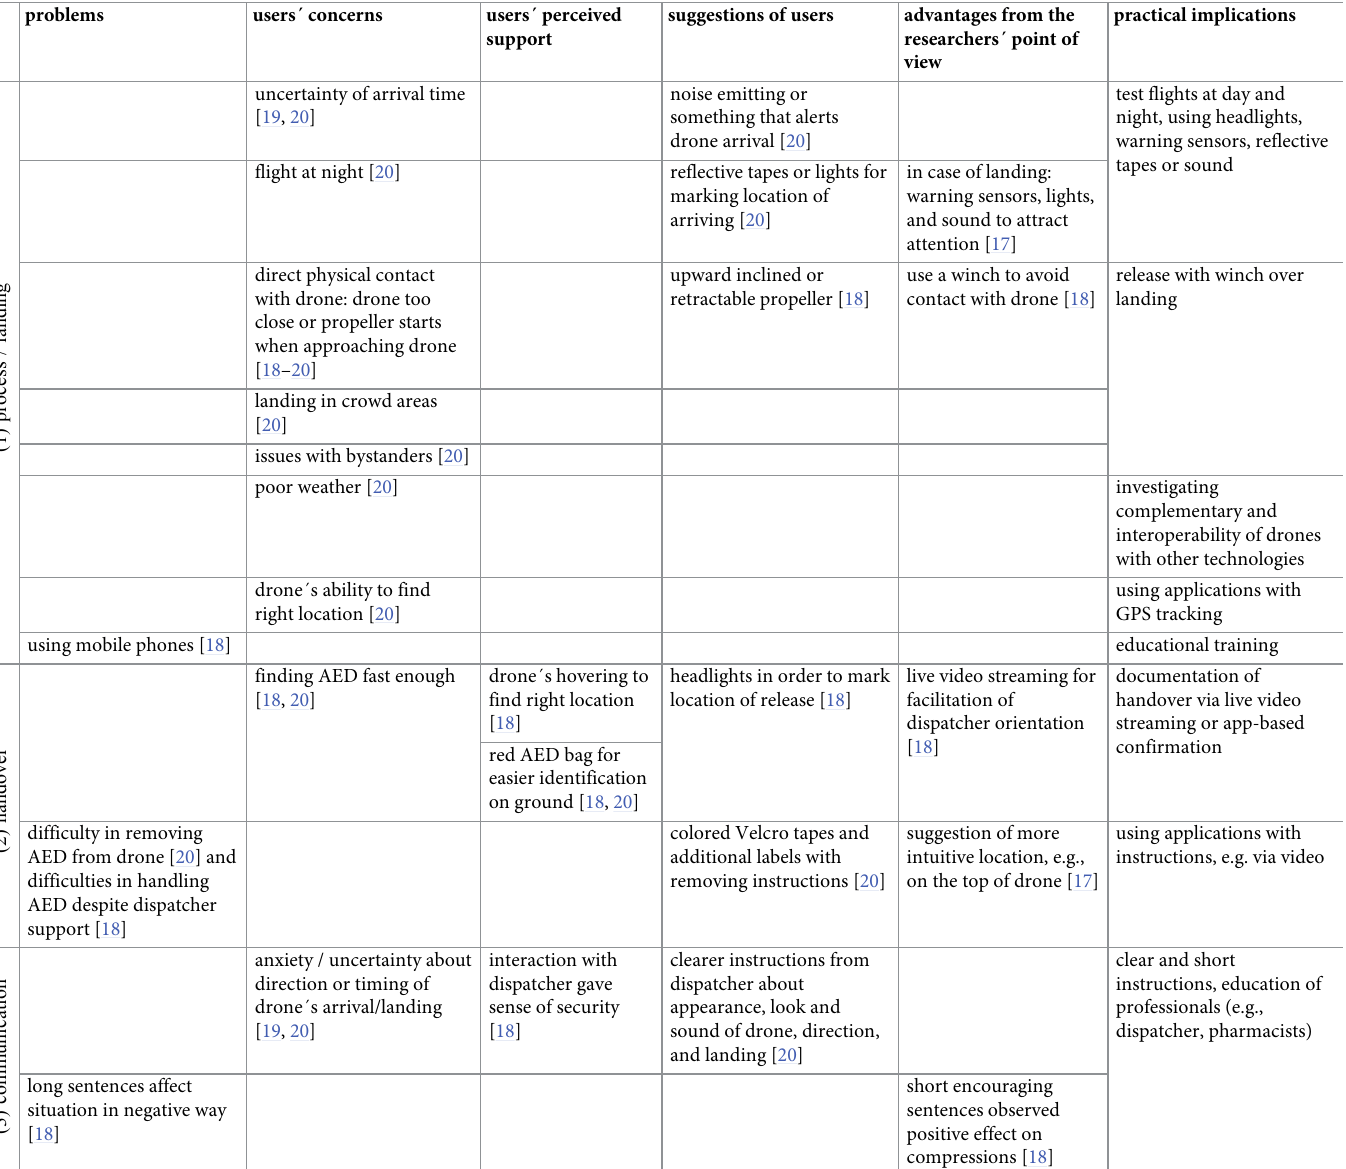
Table 4. User experience, feedback, and practical